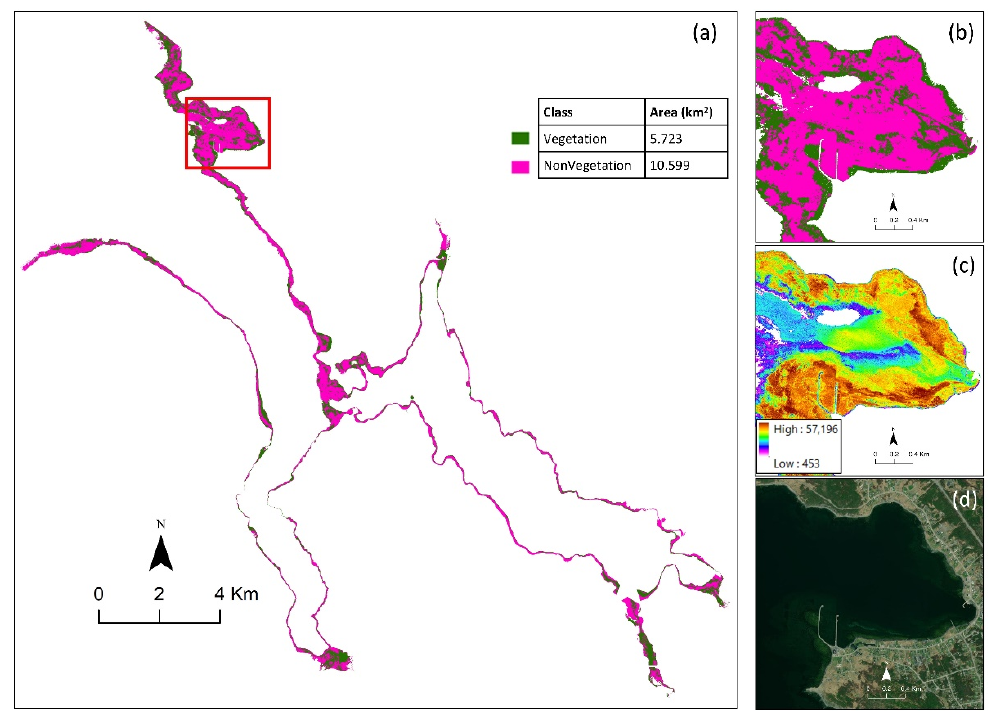
Figure 7. ( a ) Habitat map of Bonne Bay based on the Category 1 classes. ( b ) A zoomed area (red boundary in ( a )) from the map along with the ( c ) LiDAR intensity image and ( d ) very high-resolution Google Earth imagery to demonstrate the visual accuracy of the map.